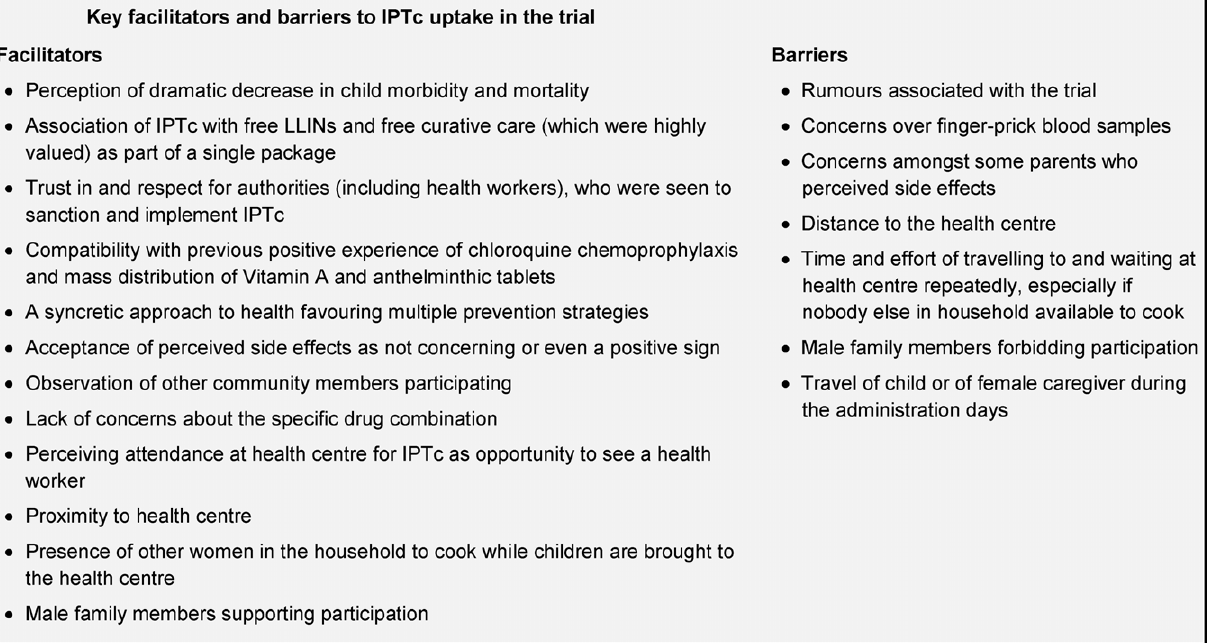
Figure 2. Key facilitators and barriers to IPTc uptake in the trial.